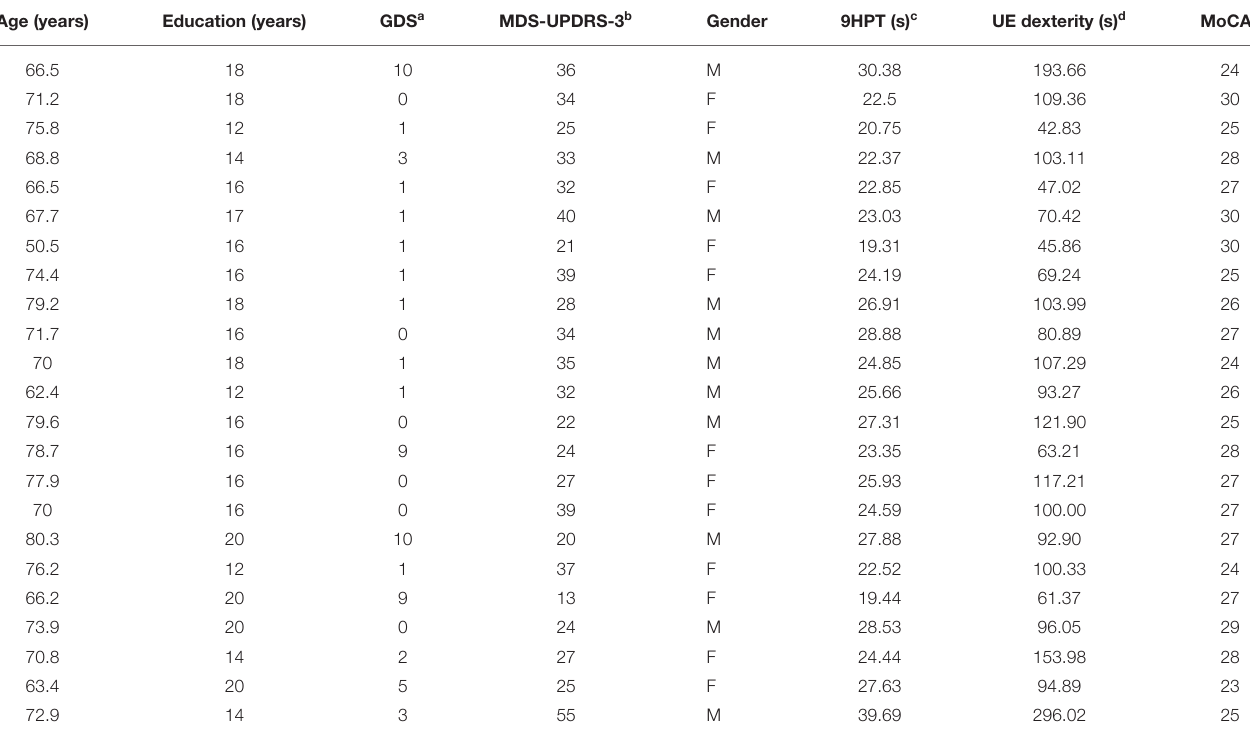
TABLE 1 | Individual participant characteristics ( n = 23).